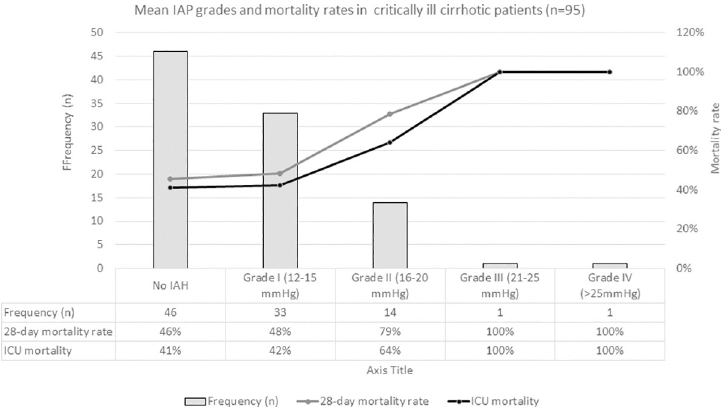
Fig 3. Distribution of IAH grades for mean intra-abdominal pressure and mortality rates in critically ill liver cirrhotic patients. Abbreviations: IAH–Intra-abdominal hypertension; ICU–intensive care unit.